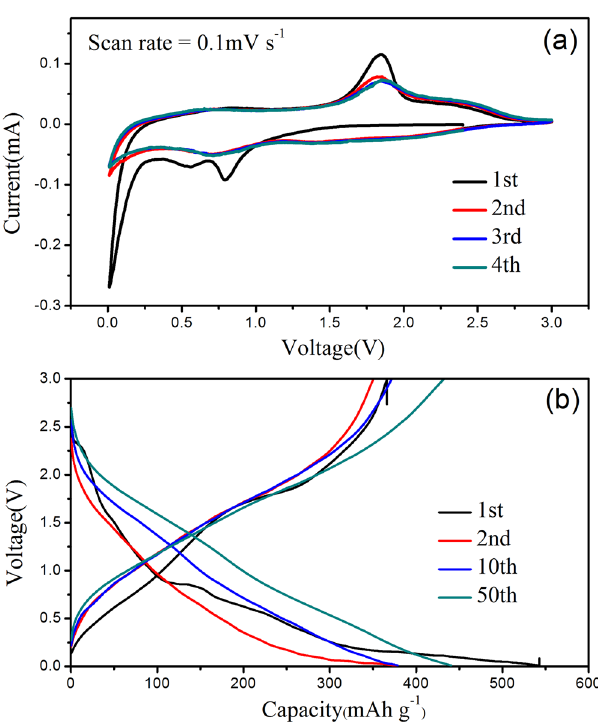
Figure 5. ( a ) CV curves at a potential sweep rate of 0.1 mV s − 1 and ( b ) discharge profiles of the MoS 2 @rGO-2 composite at 0.2 A g − 1